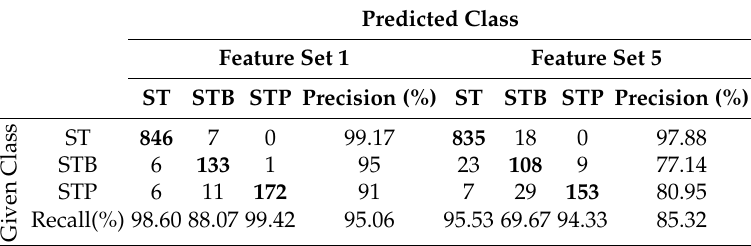
Table 8. Confusion metrics for fs1 and fs5 at the RH position achieved through decision tree